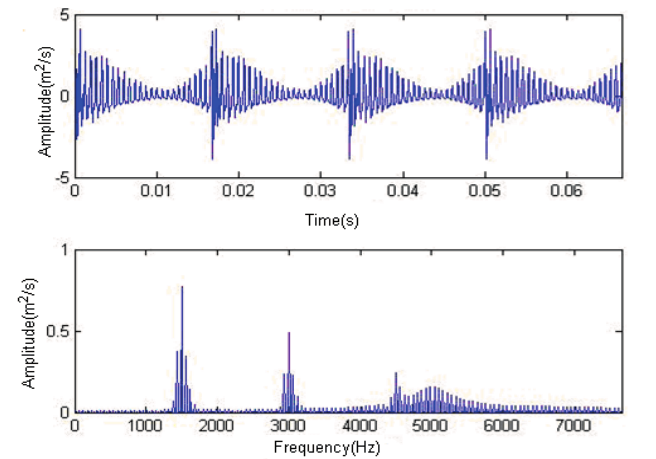
Figure 1. Signal waveform and frequency spectrum.